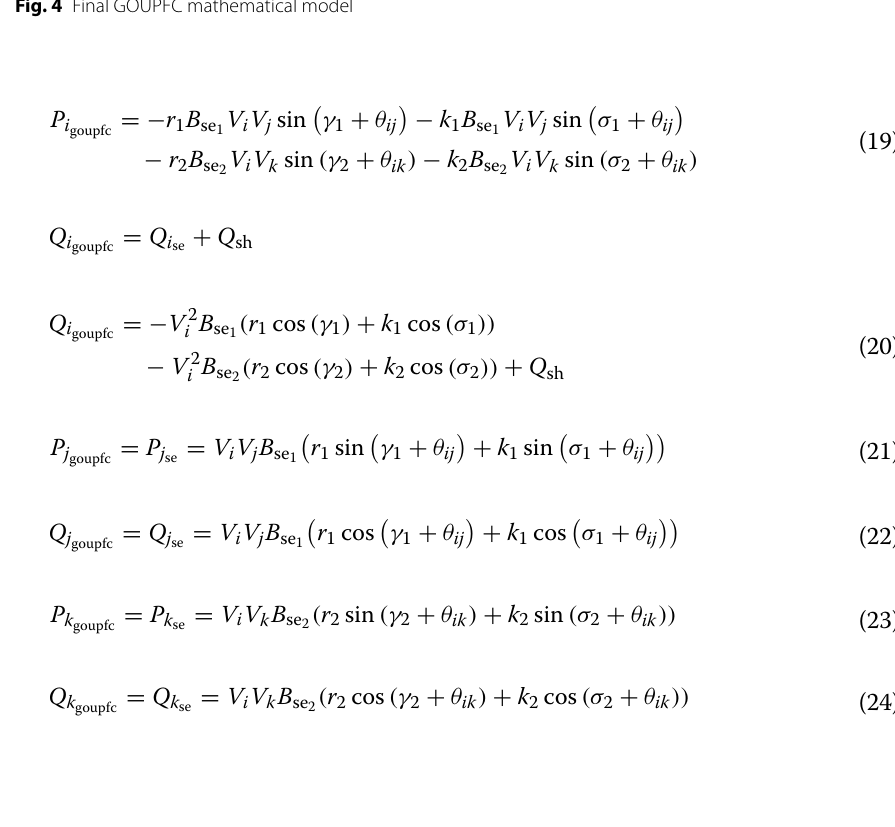
Fig. 4 Final GOUPFC mathematical